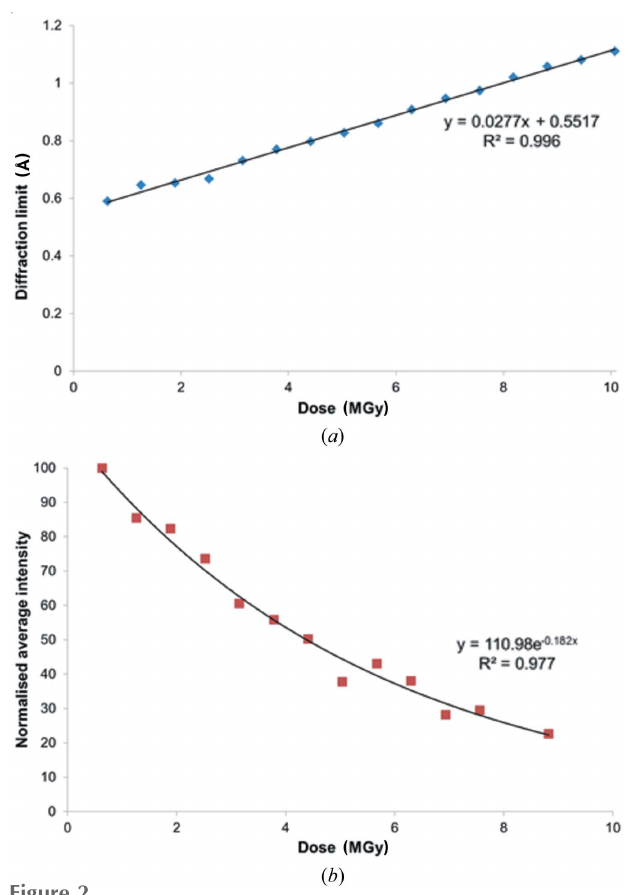
Figure 2 Results from experiment 1. The effect of sample decay at 100 K on ( a ) diffraction limit and ( b ) normalized average intensity as a function of dose.